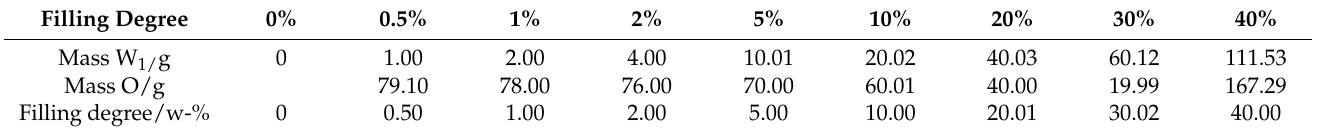
Table A2. Weights of the inner water phase and oil phase as well as the resulting filling